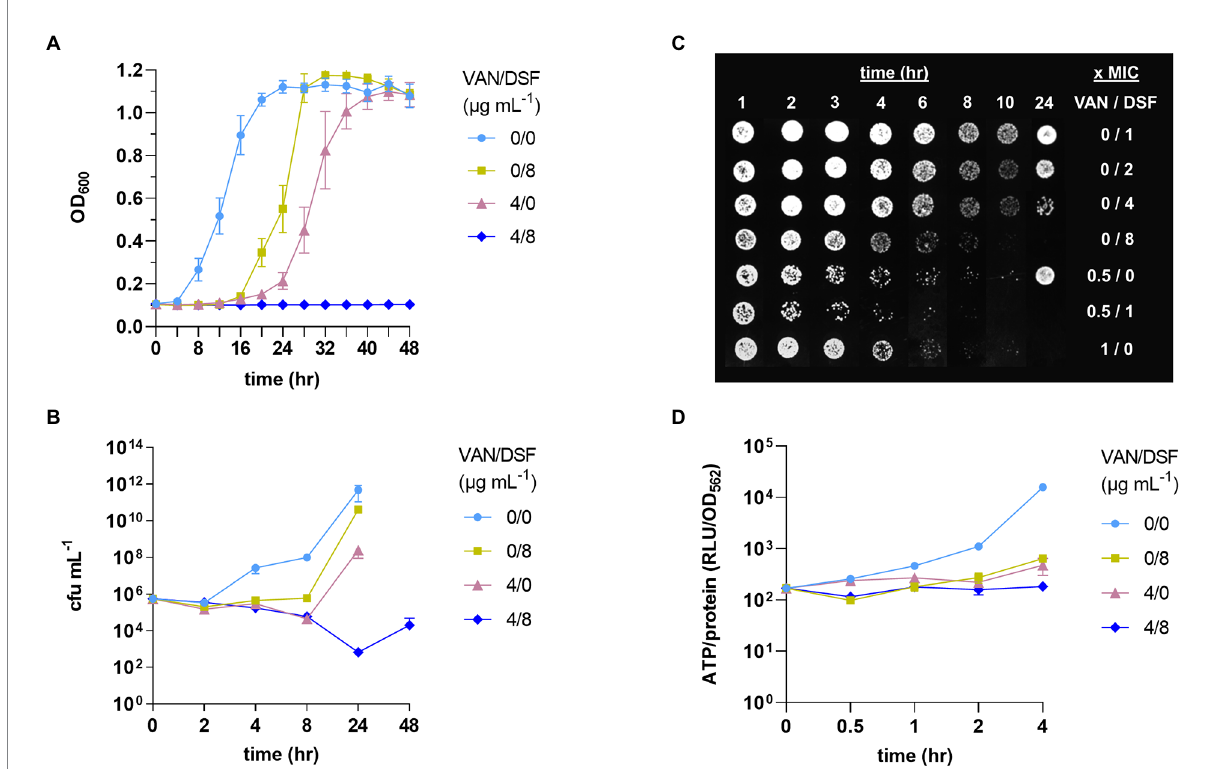
FIGURE 1 Pharmacodynamic effects of disulfiram (DSF) on VISA Mu50 treated with and without vancomycin (VAN). Treatments were compared by optical growth curves (A) , time-kill experiments (B) , cell growth on agar after 24 h (C) , and measurement of intracellular ATP levels (D)